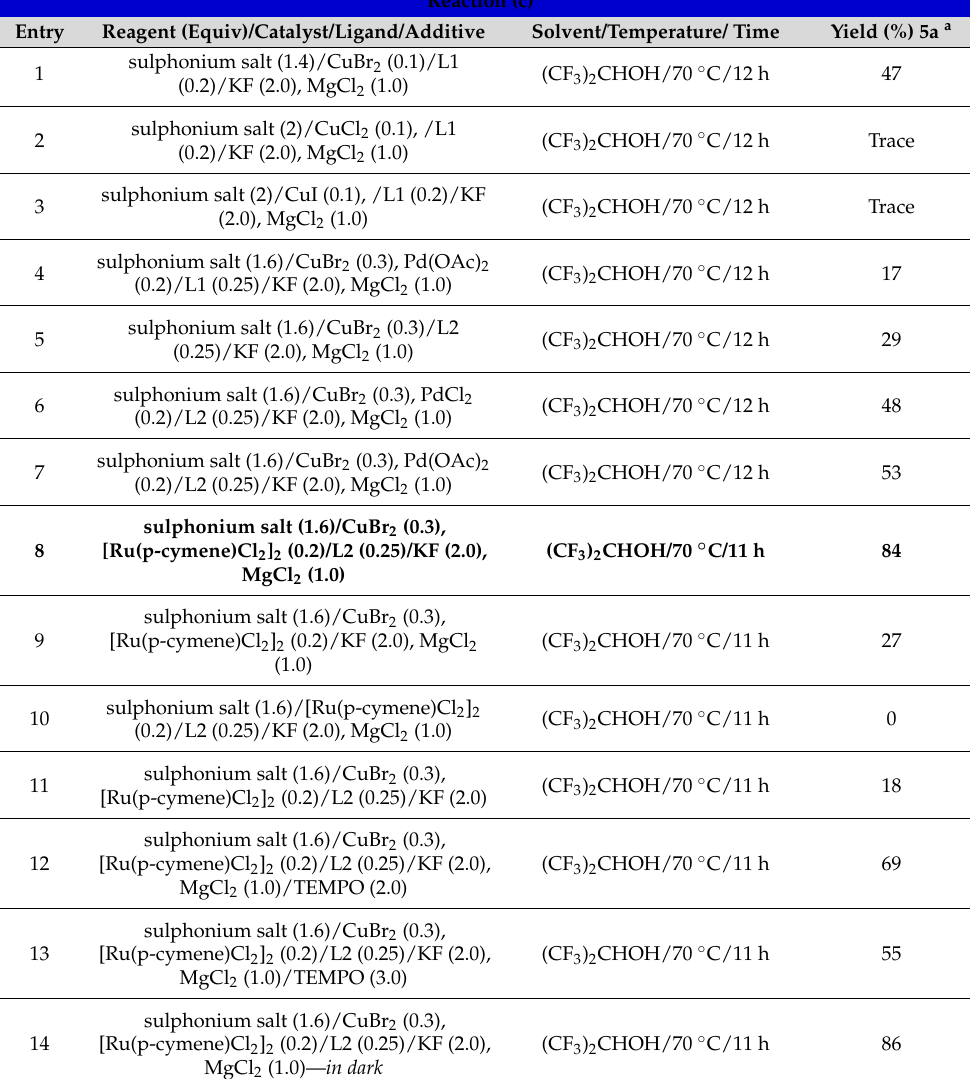
Table 3. Optimization of the reaction conditions for synthetic protocol